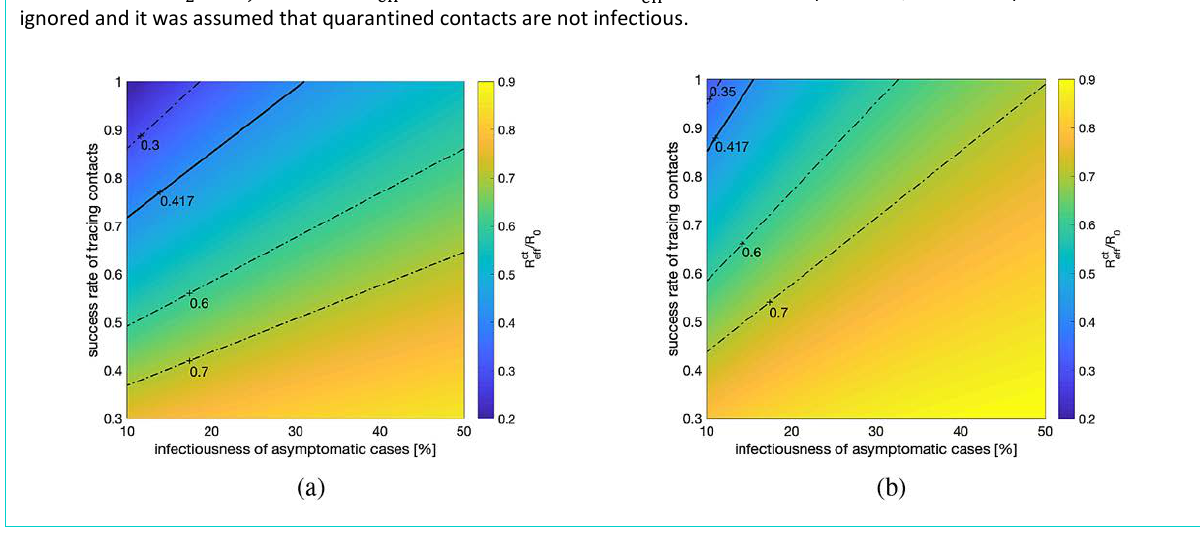
) and ); (b) of infected persons 𝑟𝑟 2 , and the bold contours 𝑟𝑟 1 = 0.33 50%